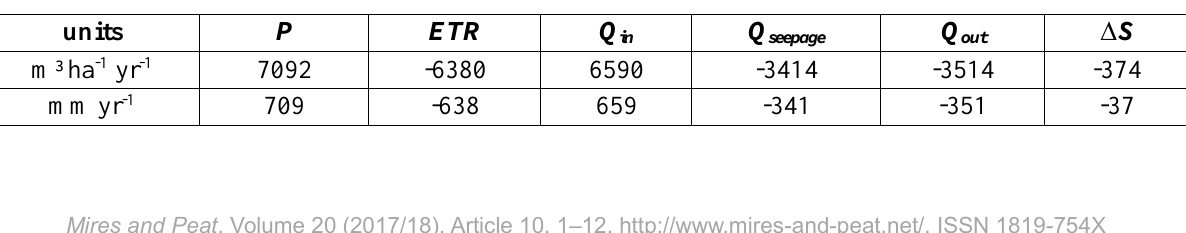
Q Q ∆ in seepage out